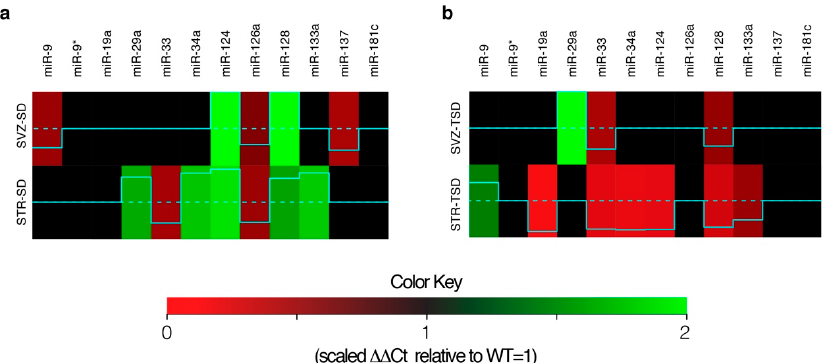
Figure 2. Heat map of miRNAs expression profile. ( a ) SVZ-SD and STR-SD; ( b ) SVZ-TSD and STR-TSD. Color nuance represents relative increase (green)/decrease (red) in miRNAs expression with respect to the related controls, SVZ-WT and STR-WT (blue dashed line). The dark color indicates a comparable expression of miRNAs in GM2 gangliosidosis mice and WT counterparts.